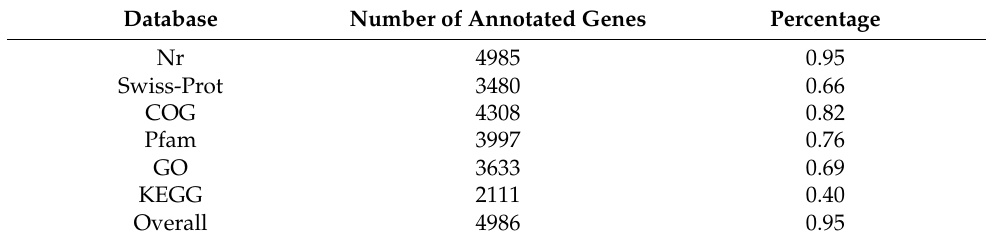
Table 1. Gene function